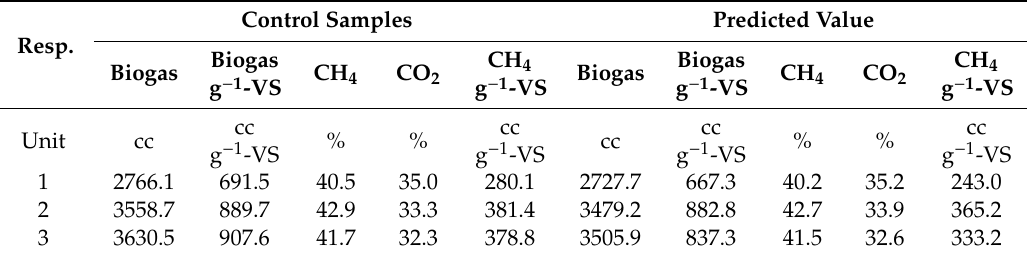
Table 4. Comparison between actual and predicted values of control